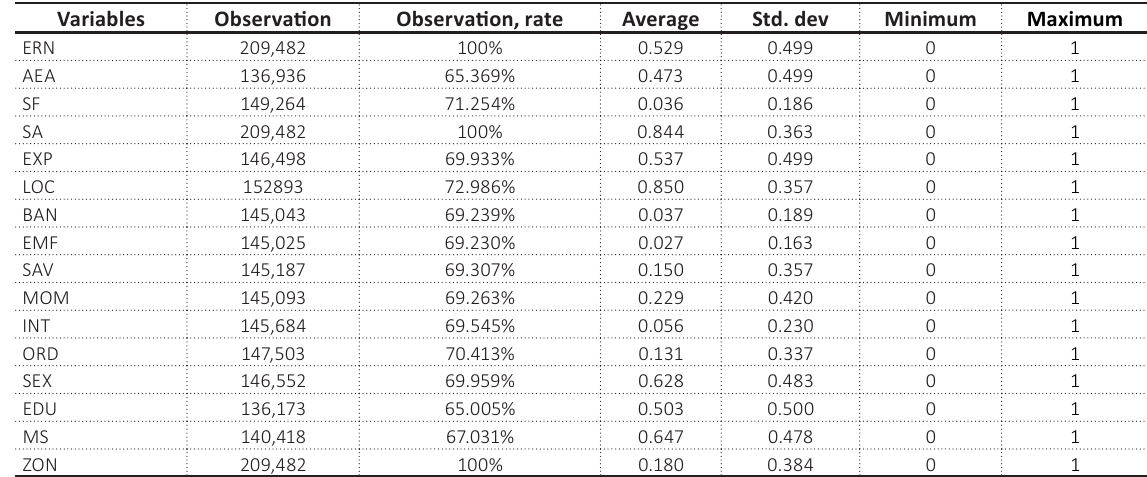
Table 1. Elements of descriptive